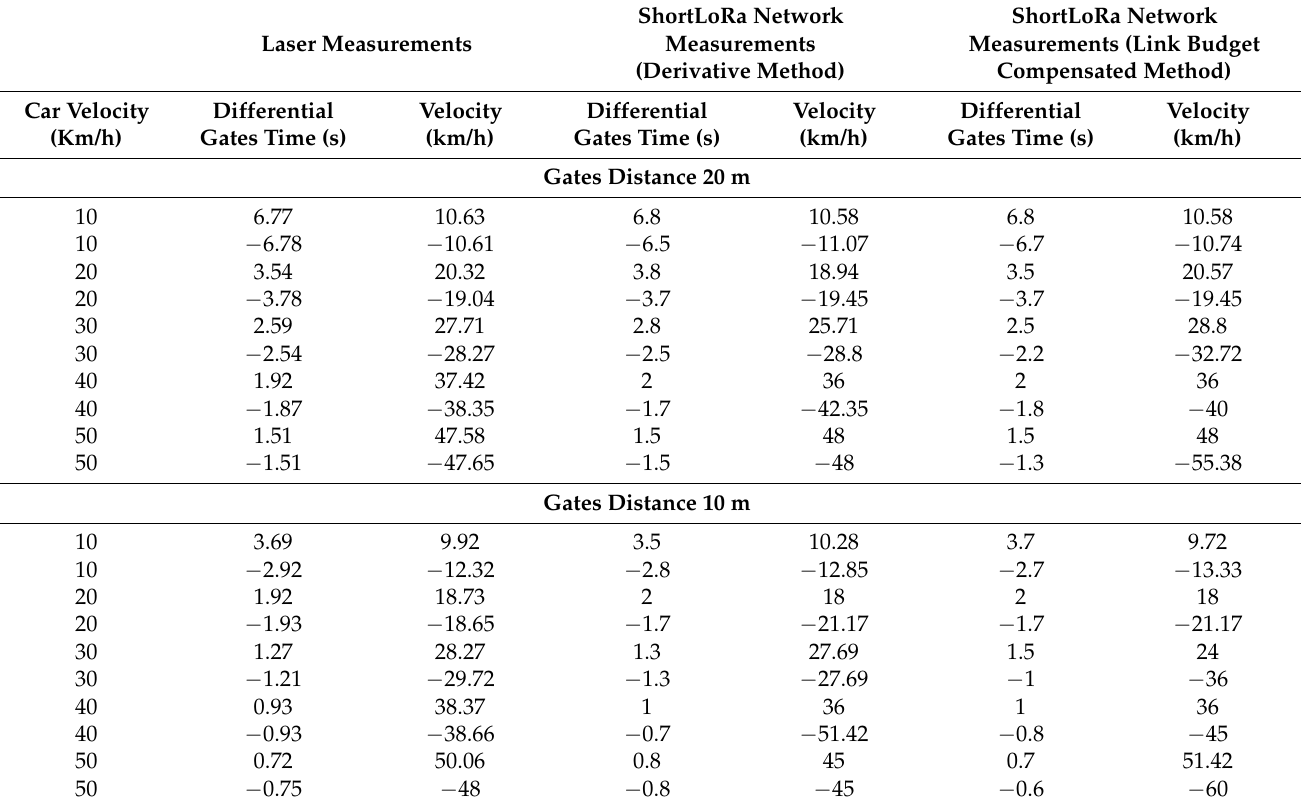
Table 7. Data analysis and speed estimation for the different processing